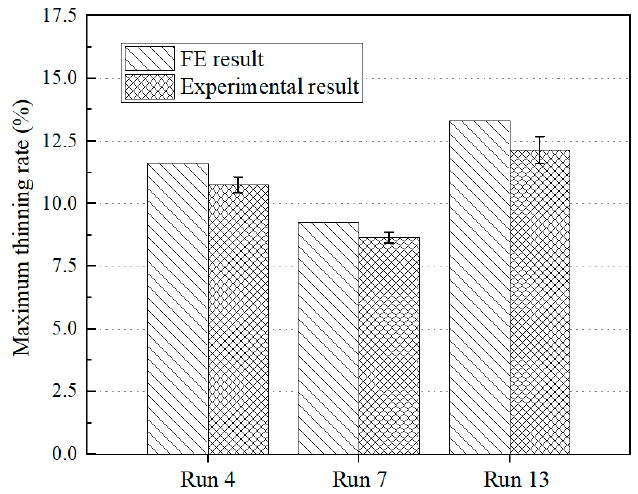
Figure 10. Comparison between simulation and testing results on the maximum thinning rate of the hot-stamped sheet. hot-stamped